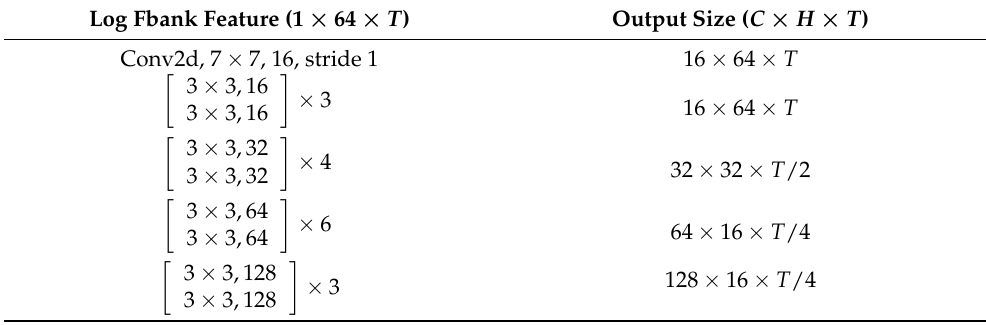
Table 1. The architecture of Thin ResNet-34. ReLu and batch normalization layers are not shown. Log Fbank Feature (1 × 64 × T ) Output Size ( C × H × T